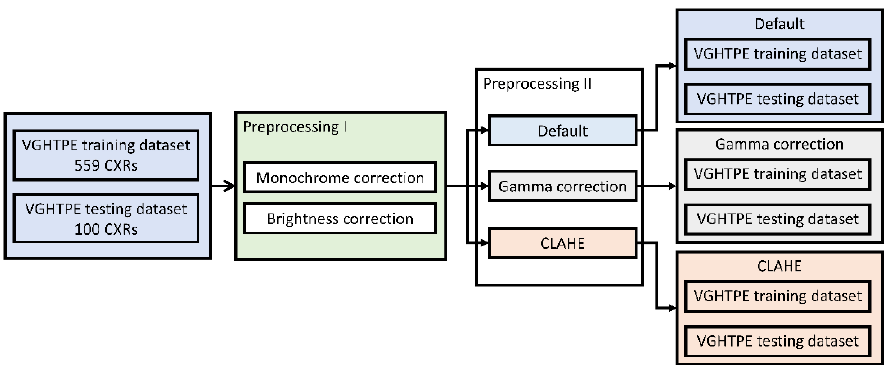
Figure 2. Preprocessing procedure.